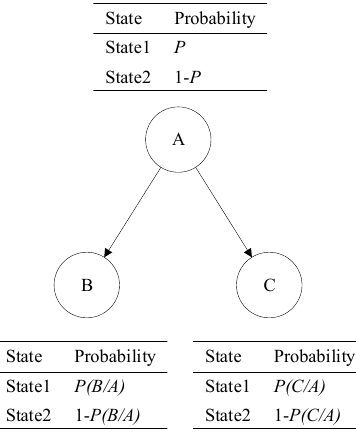
Figure 2. Typical BN diagram.